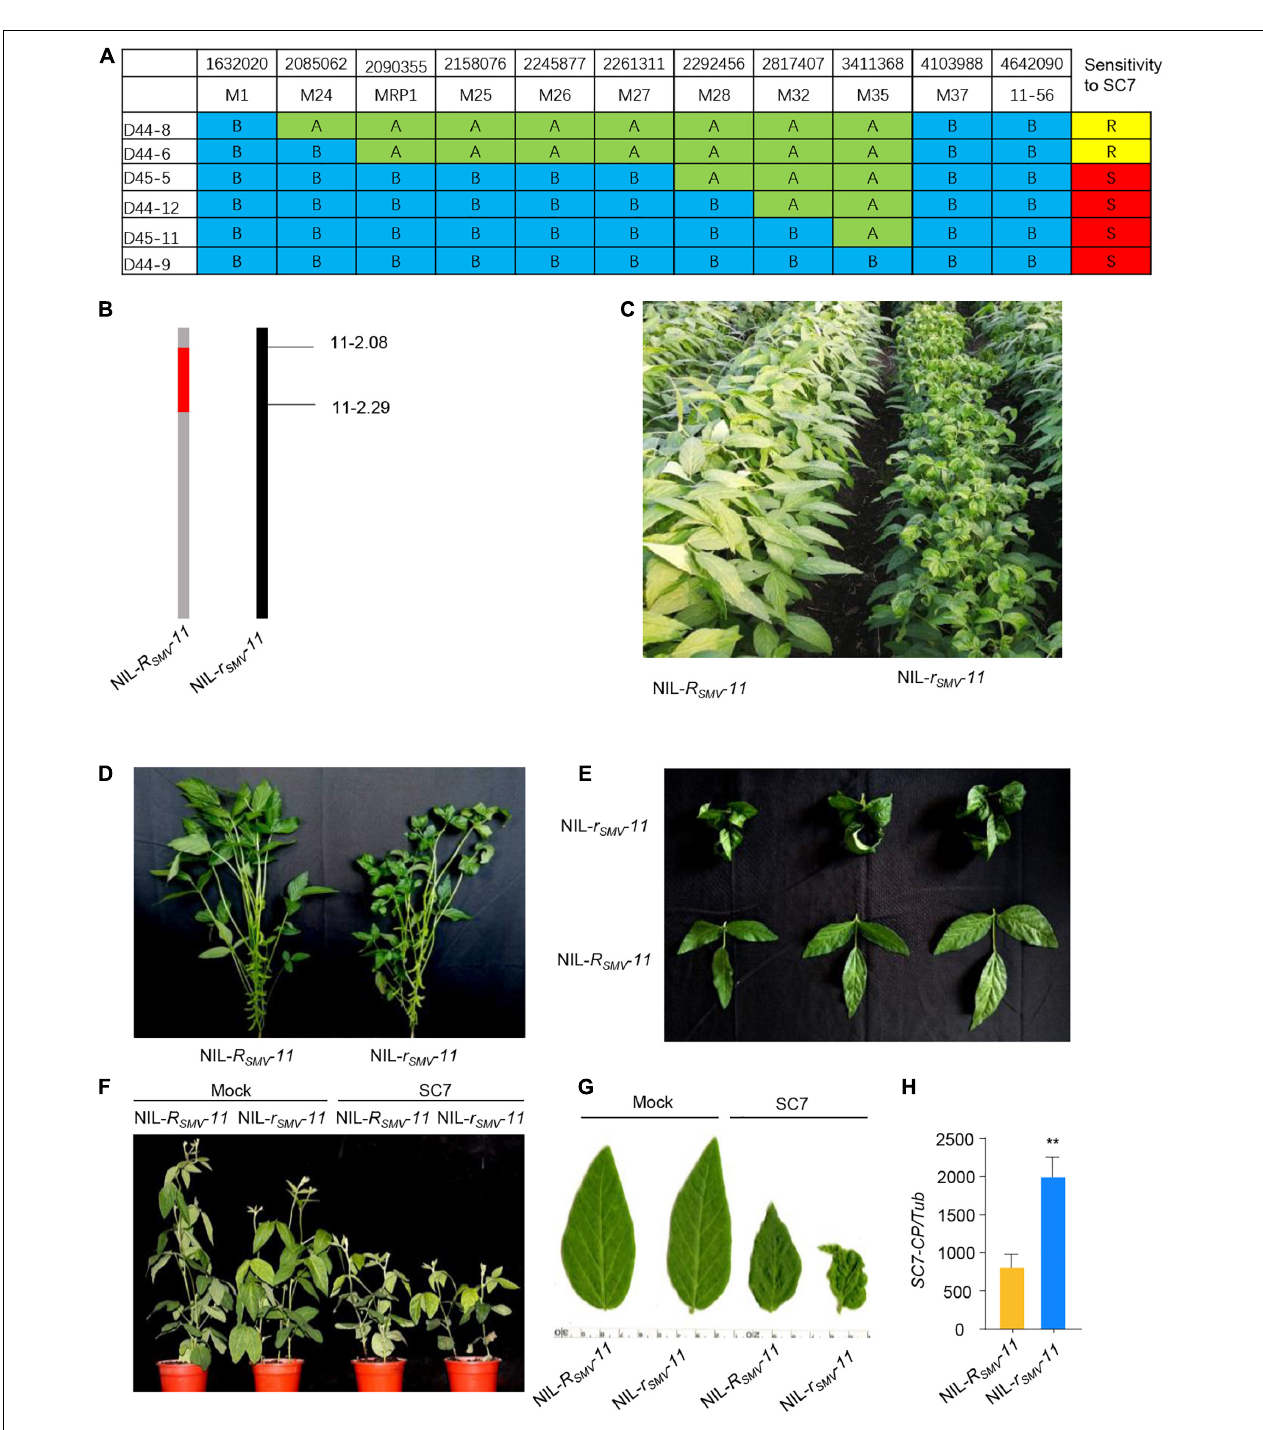
FIGURE 3 | Fine-mapping of R smv -11 . (A) Characterization of key recombinants from the F 6 segregated population in the immediate vicinity of the R smv -11 locus ( n = 36 plants). “A”, R smv -11 homozygous; “B”, r smv -11 homozygous; “H”, heterozygous. “R”, Resistant to SC7; “S”, susceptible to SC7. (B) Chromosome maps of NIL- R smv -11 and NIL- r smv -11 . Red rectangles indicate the donor segment containing the R smv -11 locus. (C,D) Phenotype of NIL- R smv -11 and NIL- r smv -11 inoculated with SC7 in the field. (E) Leaf phenotype. (F) Phenotype of NIL- R smv -11 and NIL- r smv -11 inoculated with SC7 in the greenhouse for 2 weeks. (G) Leaf phenotype. (H) Accumulation of SC7 in leaves of NIL- R smv -11 and NIL- r smv -11 treated with SC7. The amplification of soybean TUB ( GmTubulin ) gene was used as an internal control to normalize all data. Data from three biological replicates are shown, each with three technical replicates. Statistically significant differences were determined using Student’s t -test ( *P < 0.05). Error bars indicate standard error of the mean.